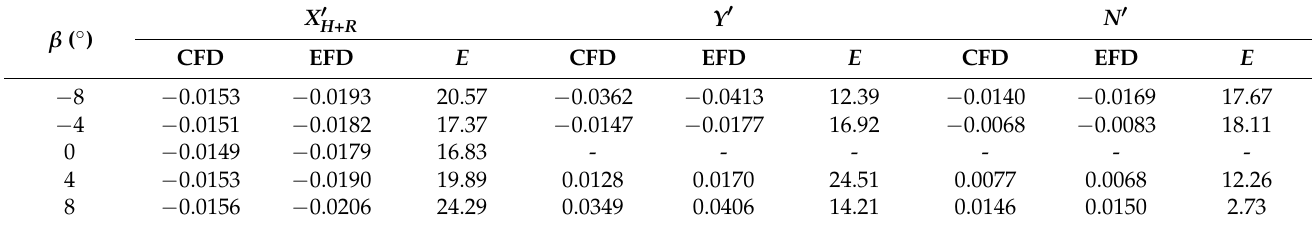
Table 14. The error between the CFD computed results and EFD data for double-body flow simulation, Fr =